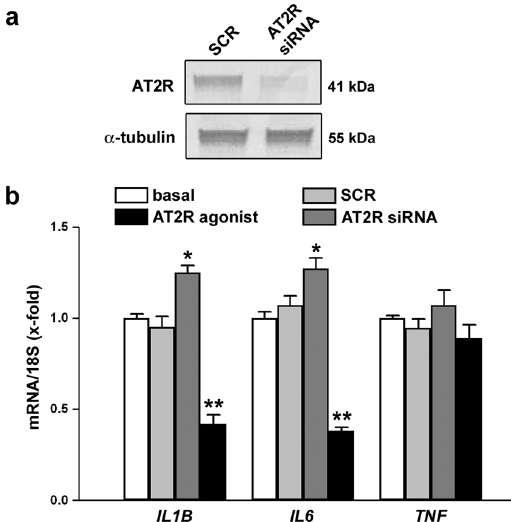
Figure 4. Effects of angiotensin II type 2 receptor (AT2R) gene silencing and AT2R activation with the agonist CGP42112A on the expression of pro-inflammatory cytokines in rheumatoid arthritis fibroblast-like synoviocytes (RA-FLS). ( a ) Verification of silencing capacity of AT2R small interfering RNA (siRNA). Protein levels of AT2R in RA-FLS transfected with AT2R siRNA or non-silencing scrambled RNA (SCR) were measured by Western blotting; α -tubulin was used as a loading control. Representative cropped immunoblots are shown. All samples were run on the same gel. Numbers on the right indicate molecular weight (kDa). ( b ) Gene expression of IL1B , IL6 and TNF was evaluated by Real-Time PCR in RA-FLS at baseline, after transfection with AT2R siRNA or non-silencing SCR, and after treatment with AT2R agonist. The mRNA expression levels were normalized to the 18 S ribosomal RNA gene. For each gene, the mRNA expression in basal cells was set to 1; the other results are expressed as x-fold increase/decrease over basal response. Bars represent the mean ± SEM. Results are representative of three independent experiments performed with each one of the six RA-FLS lines. Statistical analysis was carried out with Student’s t test; * p < 0.05, ** p < 0.001 versus the respective basal condition.